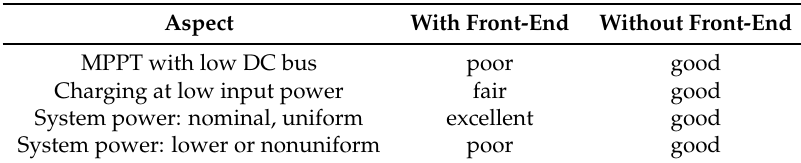
Figure 9. The system’s ( a ) output power and ( b ) efficiency for each irradiance case. Table 3. Performance Comparison of DPP